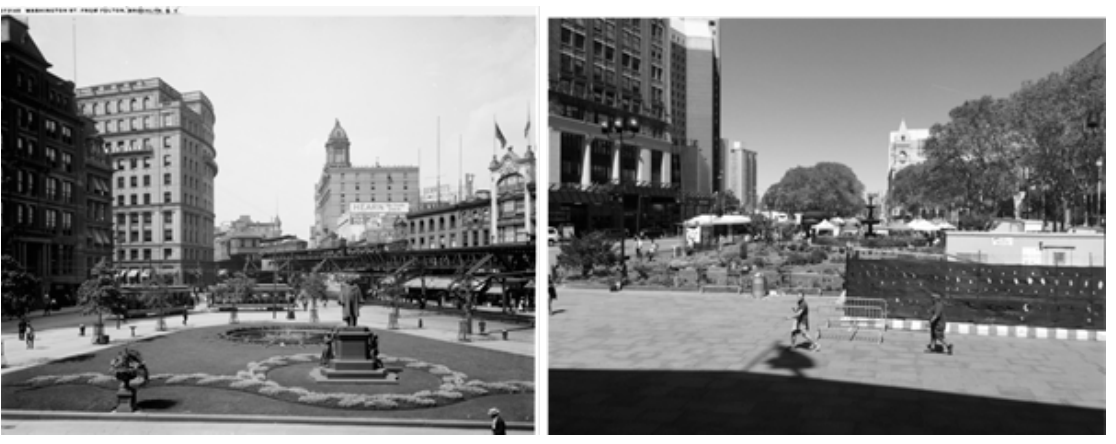
Figure 9. Left: Washington St. from Fulton ca. 1900–1920, looking north from City Hall Square; right: a similar view in 2016 (Sources: Detroit Publishing Company photograph collection, Library of Congress Prints and Photographs Division, 2016 photo by